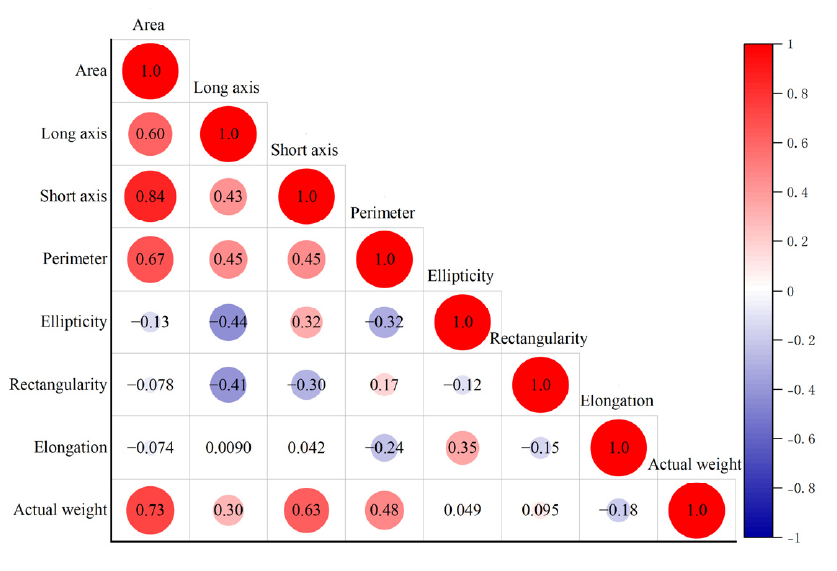
Figure 8. Matrix of the correlation coefficients between the phenotypic characteristics and thousand seed weight of Luomai 26.